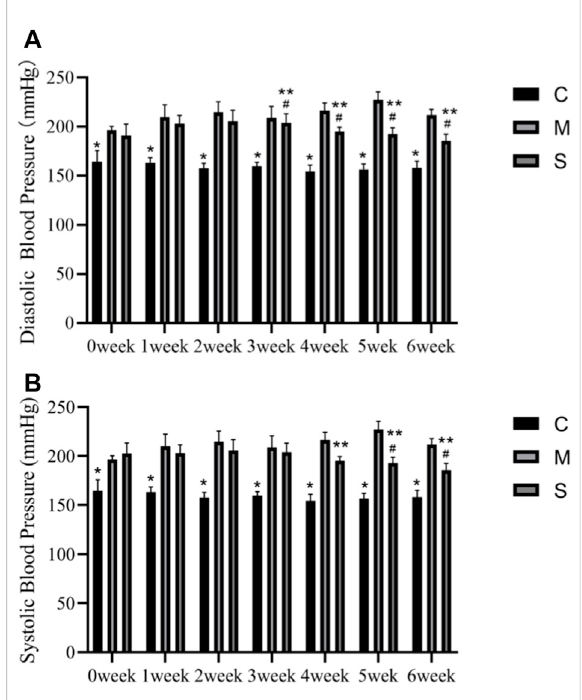
FIGURE 1 (A) Diastolic blood pressure in the normal control (C), SHR model (M) and hawthorn treated (S) rats. (B) Systolic blood pressure in the normal control (C), SHR model (M) and